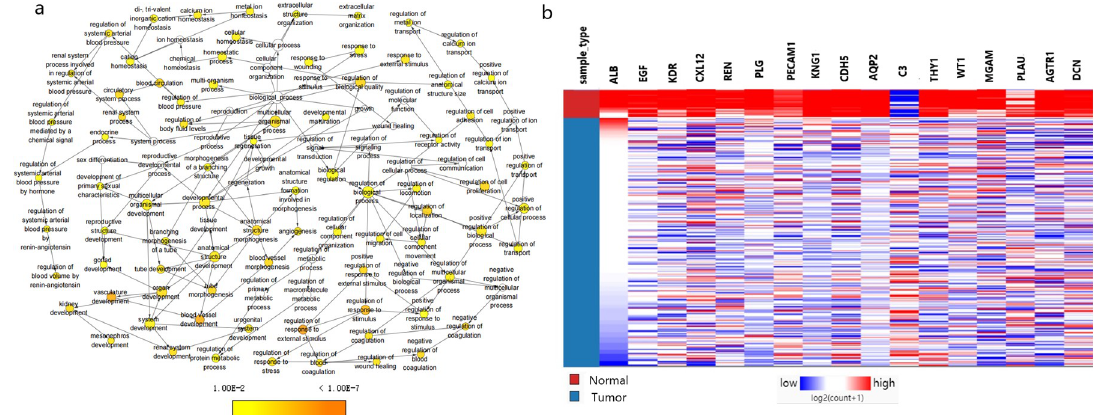
Fig 4. Biological process analysis and heatmap of the hub genes. (a) Biological process analysis of hub genes was performed using BiNGO. The colour depth of the nodes represents the corrected P value of the ontology. The size of the nodes represents the numbers of genes that are involved in the ontology. P < 0.01 was considered statistically significant. (b) A heatmap of hub gene expression was constructed using the UCSC online database. Normal samples are shown in red, and PRCC samples are shown in blue. Red represents upregulated genes, and blue represents downregulated